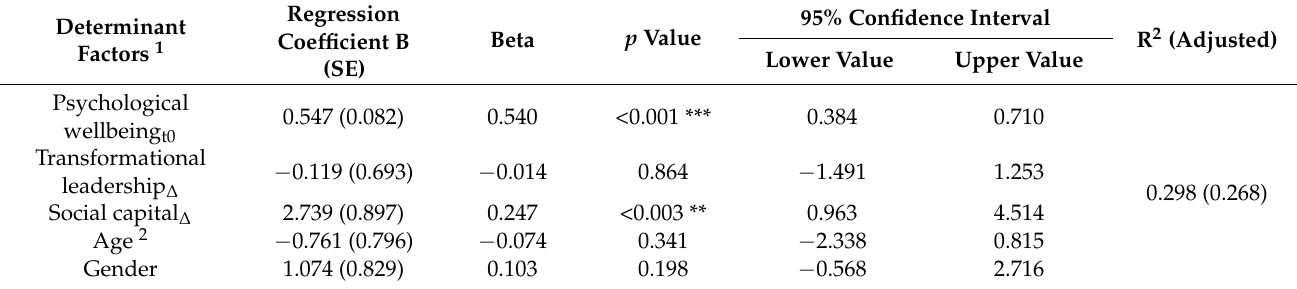
Table 5. Multiple linear regression analysis, model